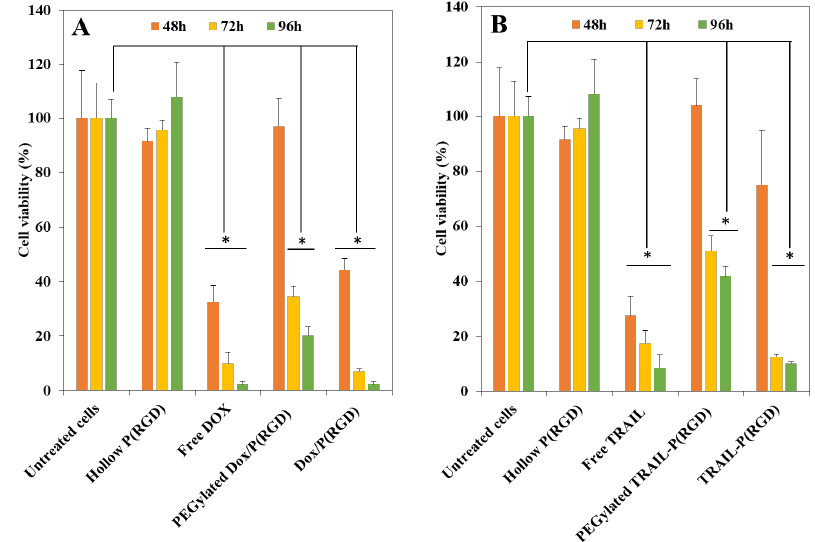
Figure 7. Cell viability of untreated and CAOV-3 treated cells after 48 h (orange), 72 h (yellow) and 96 h (green) with hollow P(RGD) NCs as control of ( A ) free Dox and Dox / P(RGD) NCs and ( B ) free 96 h (green) with hollow P(RGD) NCs as control of ( A ) free Dox and Dox/P(RGD) NCs and ( B ) free TRAIL and TRAIL-P(RGD) NCs. * T test p < 0.05, error bars represent standard deviation. TRAIL and TRAIL-P(RGD) NCs. * t test p < 0.05, error bars represent standard